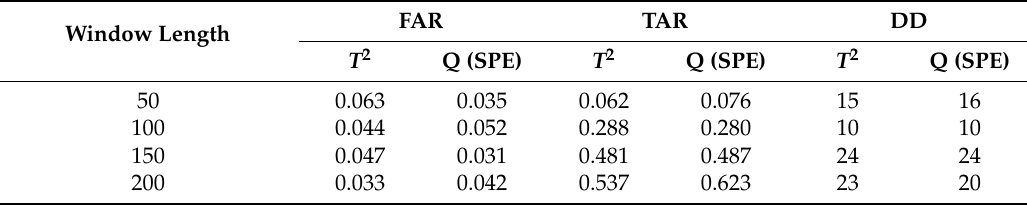
Table 2. Monitoring results on simulated dataset using Method I.